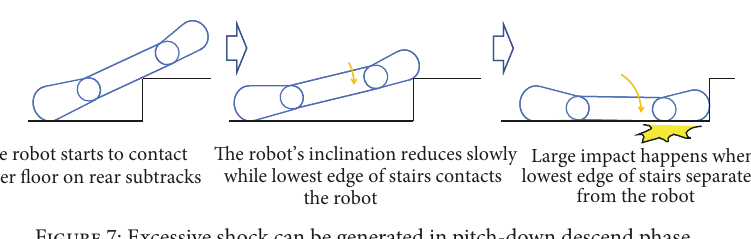
Figure 7: Excessive shock can be generated in pitch-down descend phase.